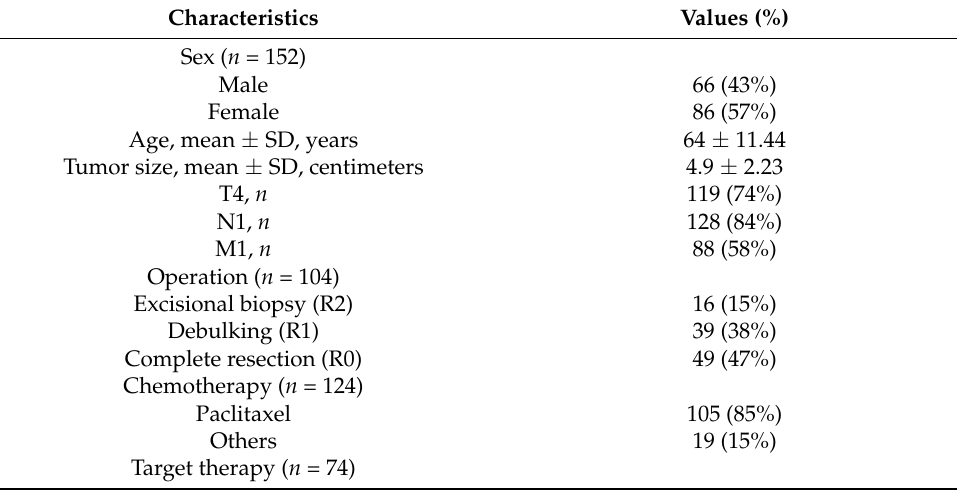
Table 1. Clinical features of patients with anaplastic thyroid cancer ( n =